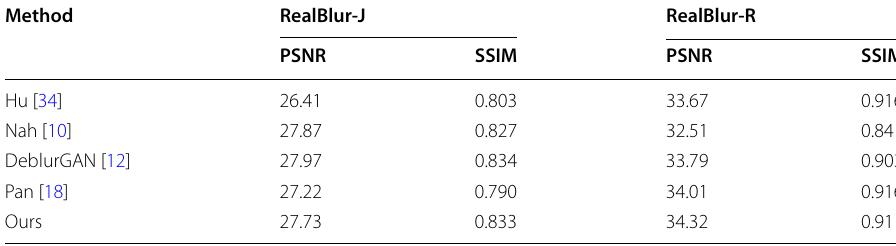
Table 3 Performance comparison on the RealBlur dataset